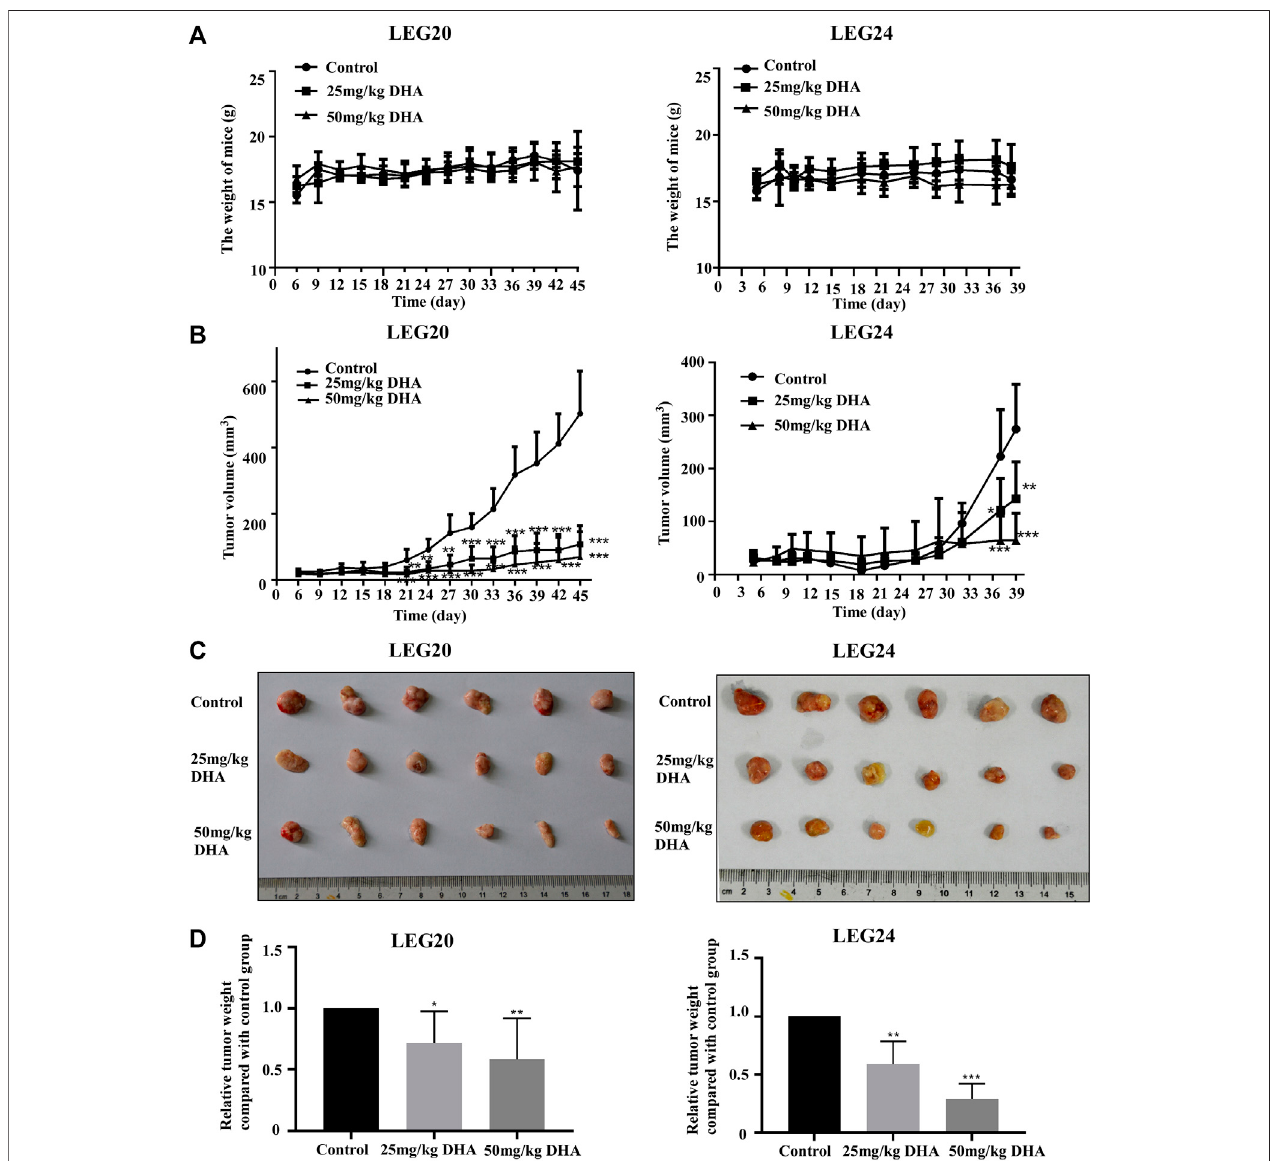
FIGURE 5 | DHA suppresses tumor growth (LEG20 and LEG24) of ESCC in vivo . (A) DHA did not affect the body weight of the mice (B) DHA inhibited the growth of xenograft tumors. Tumor volume in each mouse was measured using acaliper once every 3 days. (C) When the mice weresacri fi ced, thetumorswere extracted and photographed (D) Tumor weights were decreased in the DHA treatment group, con fi rmed by analyzing the weight of tumors in each group (*, p < 0.05; **, p < 0.01; ***, p < 0.001; n (cid:2) 6 per group, one-way ANOVA).